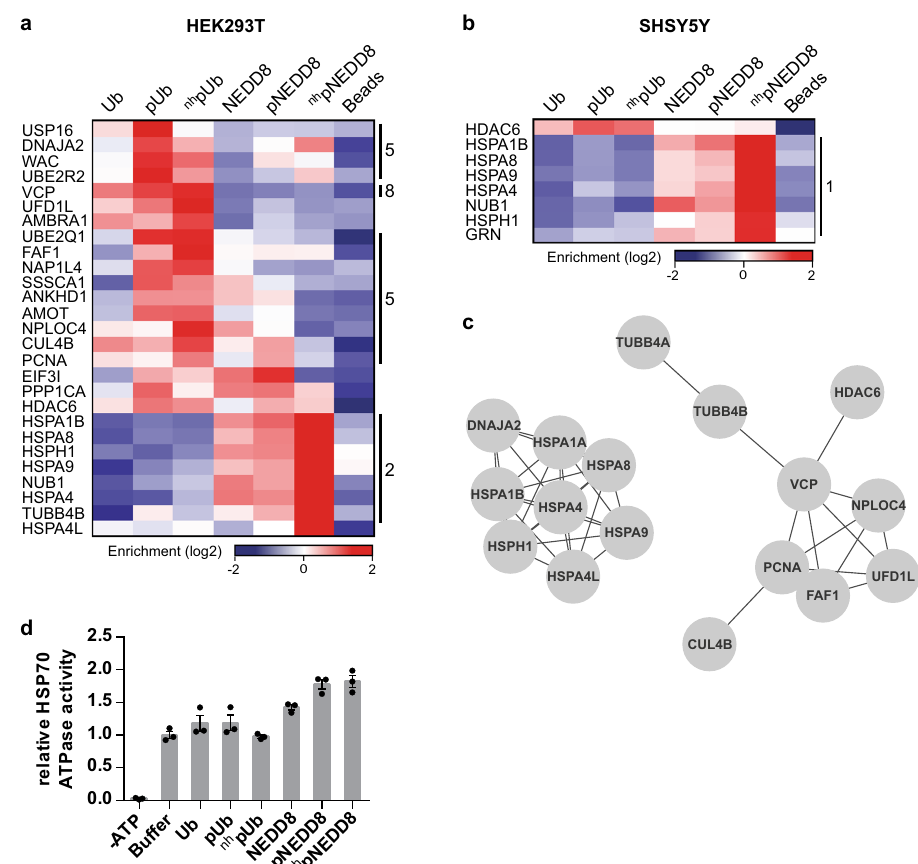
Fig. 6 pNEDD8 but not pUb stimulates HSP70 ATPase activity. a , b Selected proteins from the AE-MS experiments performed with HEK293T ( a ) or SHSY5Ycell ( b ) extracts with a binding preference for pUb or pNEDD8. Thresholds for the ANOVA statistics were set as follows: FDR = 0.02, S0 = 1. Enrichment is indicated in red, whereas lack of enrichment is indicated in blue. Clusters are as in Fig. 4b. c String interaction networks showing only interactions with the highest con fi dence (interaction score 0.9) for the proteins selected in a and b . d The relative stimulation of the ATPase activity of HSPA8, a member of the HSP70 family, was measured in presence of Ub, pUb, nh pUb, NEDD8, pNEDD8, and nh pNEDD8 and compared to HSP70 basal ATPase activity ( n = 3 ± SEM independent experiments). Source data are provided as a Source Data fi